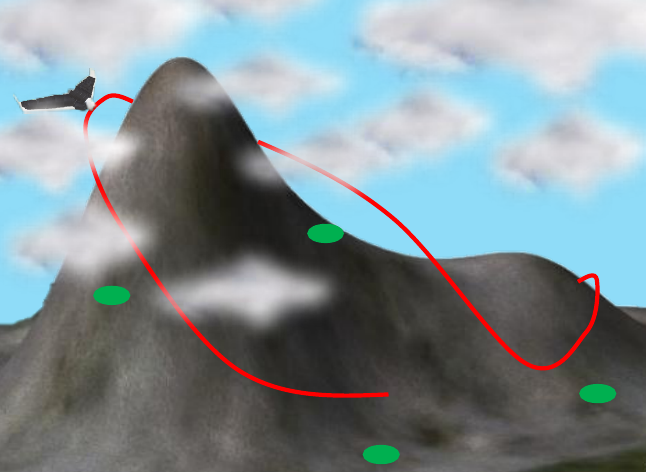
Figure 1. Inspecting mountain sites by a solar-powered unmanned aerial vehicle